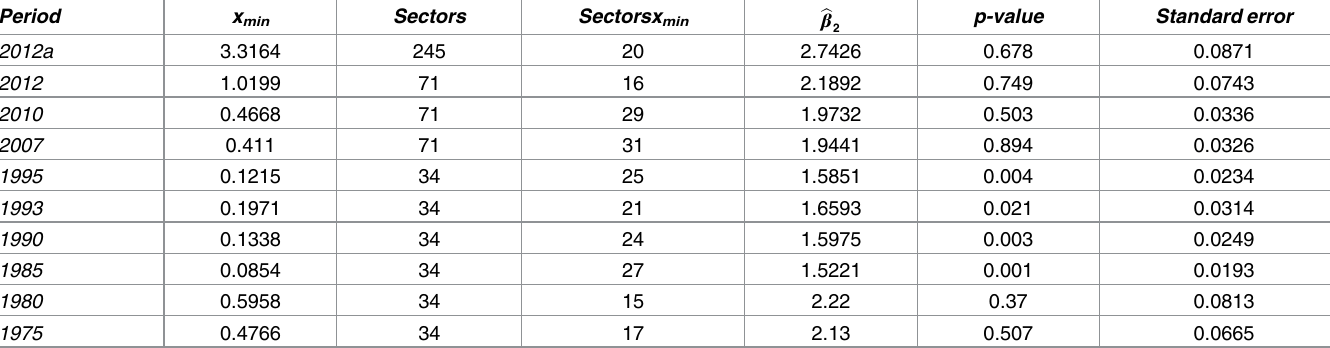
Table 3. Power law test for second-order degrees of production.